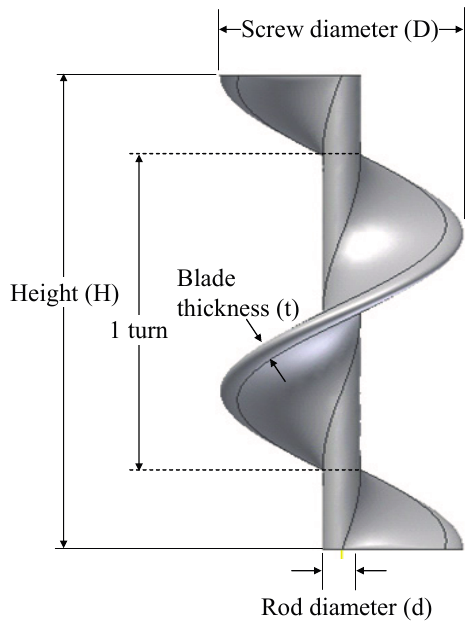
Figure 1. The two-photon polymerization (TPP) fabrication system.